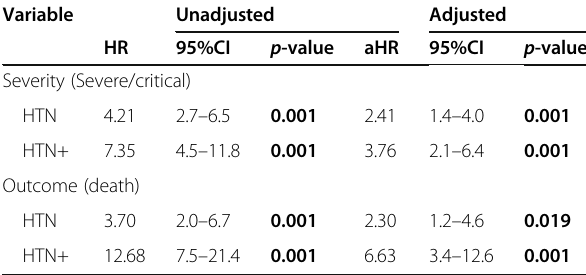
Table 4 Cox regression for risk of increased severity and death among patients with hypertension compared with patients without hypertension. (adjusting for sex and